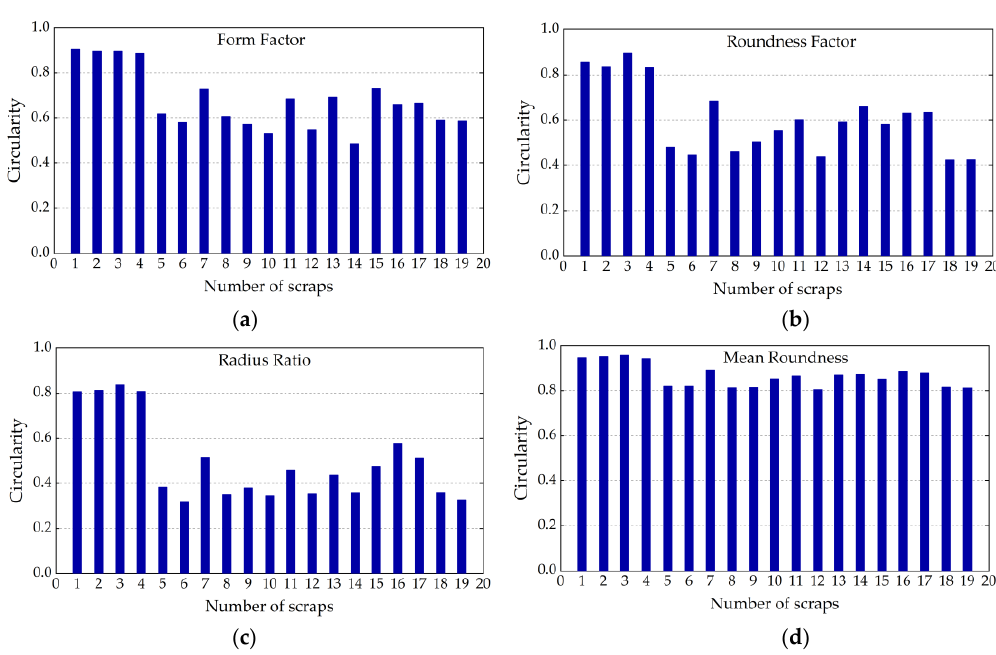
Figure 13. Bar plots of measurement results: ( a ) Form Factor; ( b ) Roundness Factor; ( c ) Radius Ratio; and, ( d ) Mean Roundness.